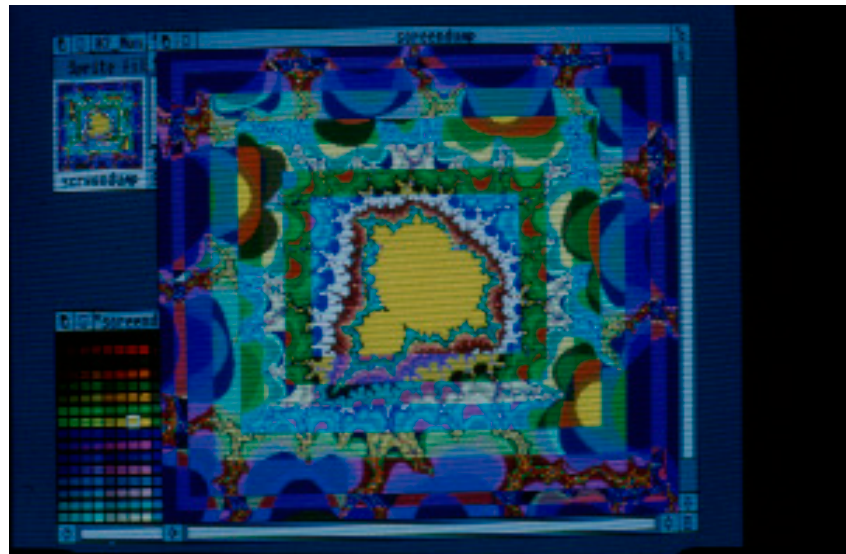
Figure 13. A screenshot, apparently derived from the Mandelbrot set, manipulated in a paintbox program, and captured on slide film by Ostoja. Published with permission. Image courtesy of the State Arts 2019 , 8 , x FOR PEER REVIEW Library of South Australia. SLSA: PRG 919/21/381.